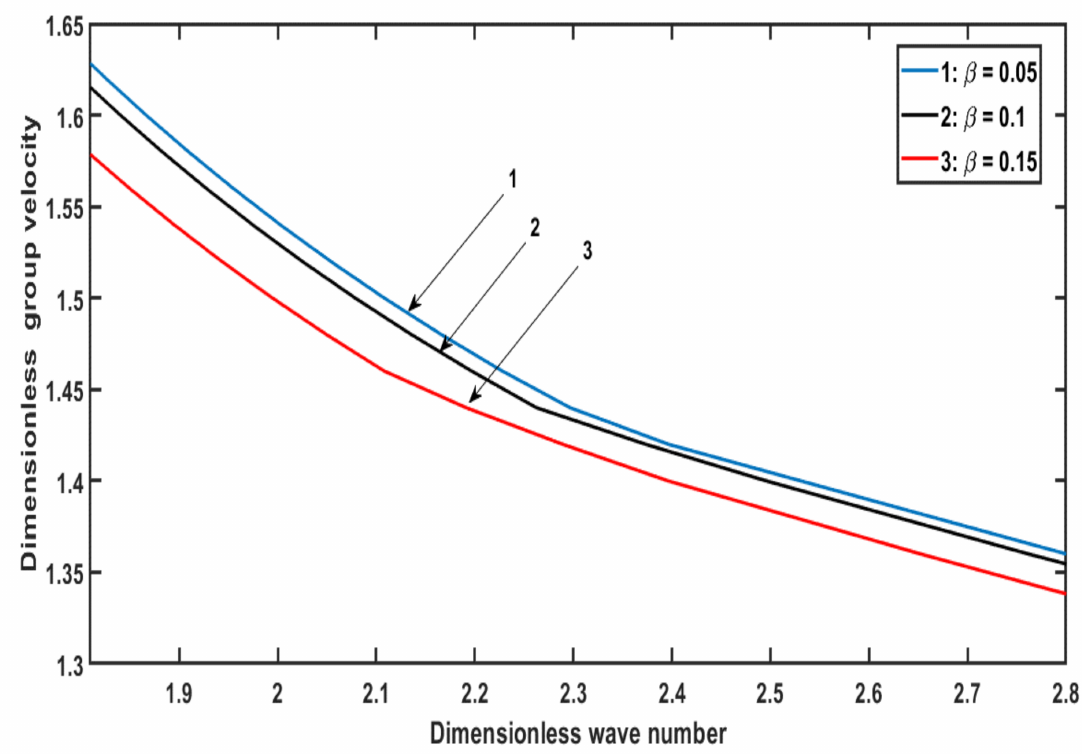
Figure 12. The group velocity with wave number when a 1 = 0.1, p = 0.01, m = 0.08, a 2 = 0.2, α = 0.2, h =